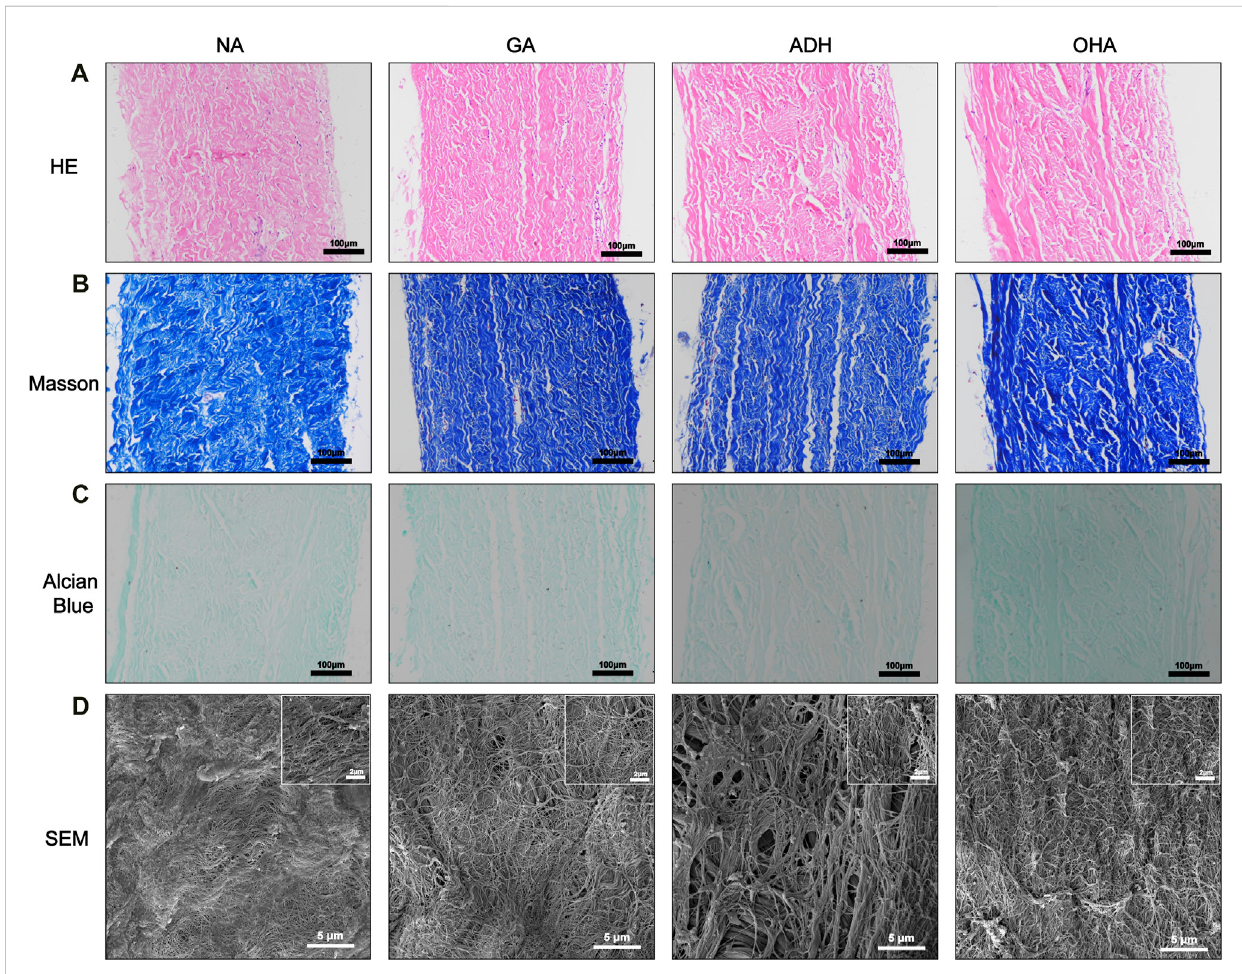
FIGURE 3 Histological staining and SEM images of the three groups. The images show HE staining (A) , Masson ’ s trichrome staining (B) , Alcian blue staining (C) and SEM (D) .